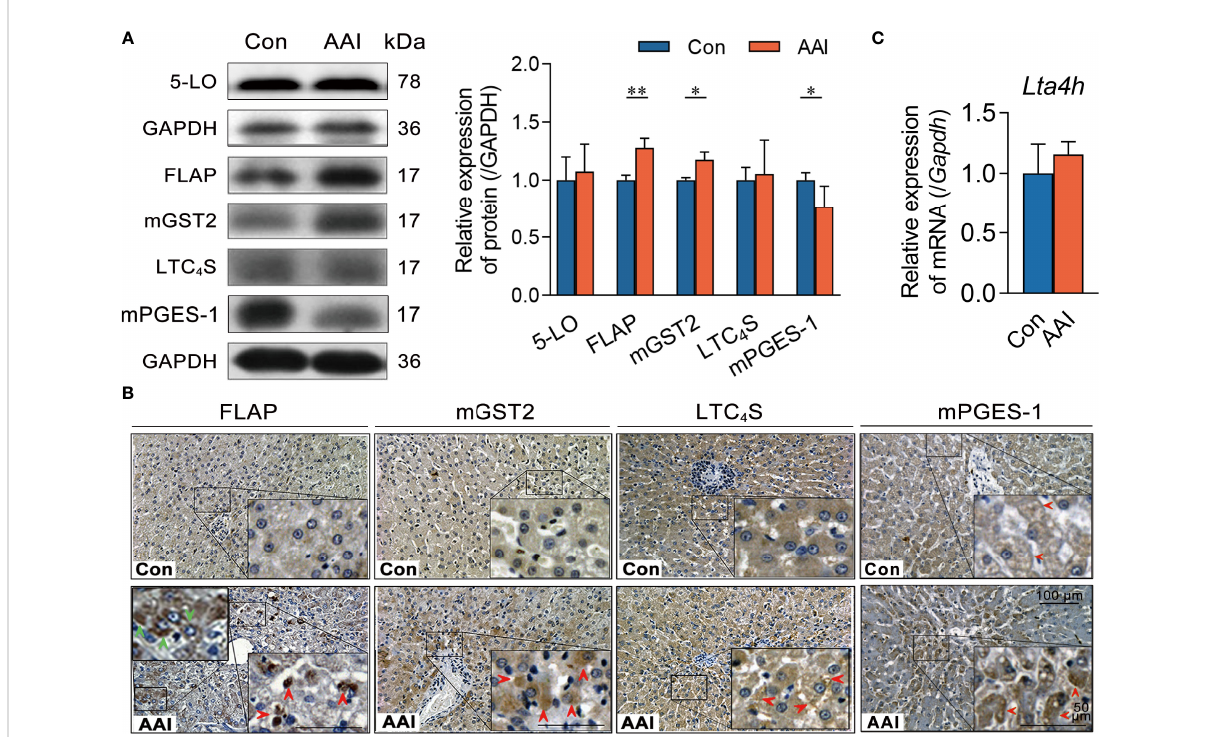
FIGURE 5 AAI treatment leads to FLAP overexpression in canine livers. Liver tissues were obtained from canines after treatment with AAI (3 mg/kg/day) or fi ller only (negative control, Con) for 10 days. (A) Representative Western blotting of the catalytic proteins in 5-LO/CysLTs cascade and COX pathway. (B) Representative photomicrographs with immunohistochemical stains using indicated antibodies in 5-LO/CysLTs cascade and COX pathway. FLAP in hepatocytes (dark brown, green arrowheads), Kupffer cells (dark brown, red arrowheads), mGST2 (light brown, arrowheads), and LTC 4 S (arrowheads) in liver tissues. MPEGS-1 (slight brown round central veins, disappearing in elsewhere). Bar = 100 m m, bar = 50 m m (magni fi cation). (C) The transcription of hepatic Lta4h was analyzed by real-time quantitative PCR. Error bars represent the mean value ± SD; Student unpaired t- test was used to compare groups, and p- value less than 0.05 was considered as statistically signi fi cant. * p < 0.05, ** p < 0.01 vs. control. For each analysis, n = 4/per